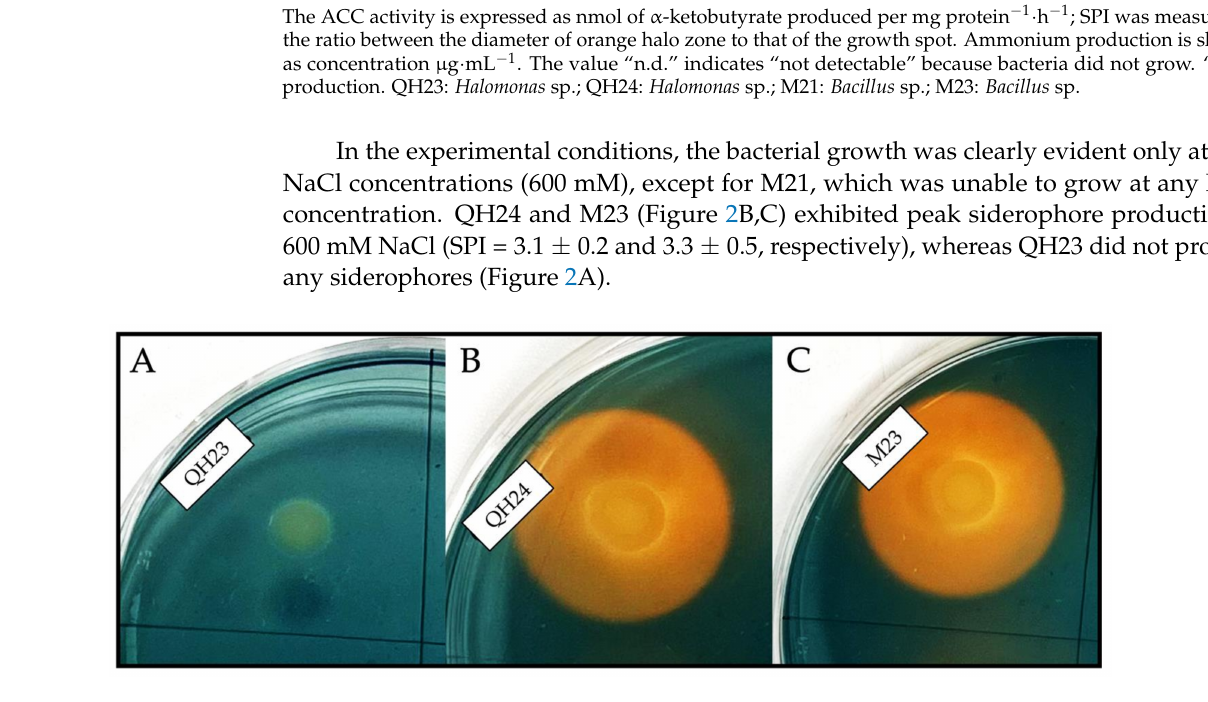
Figure 2. The siderophore production is shown as an orange halo around the growth spot. ( A ) QH23: Halomonas sp.; ( B ) QH24: Halomonas sp.; ( C ) M23: Bacillus